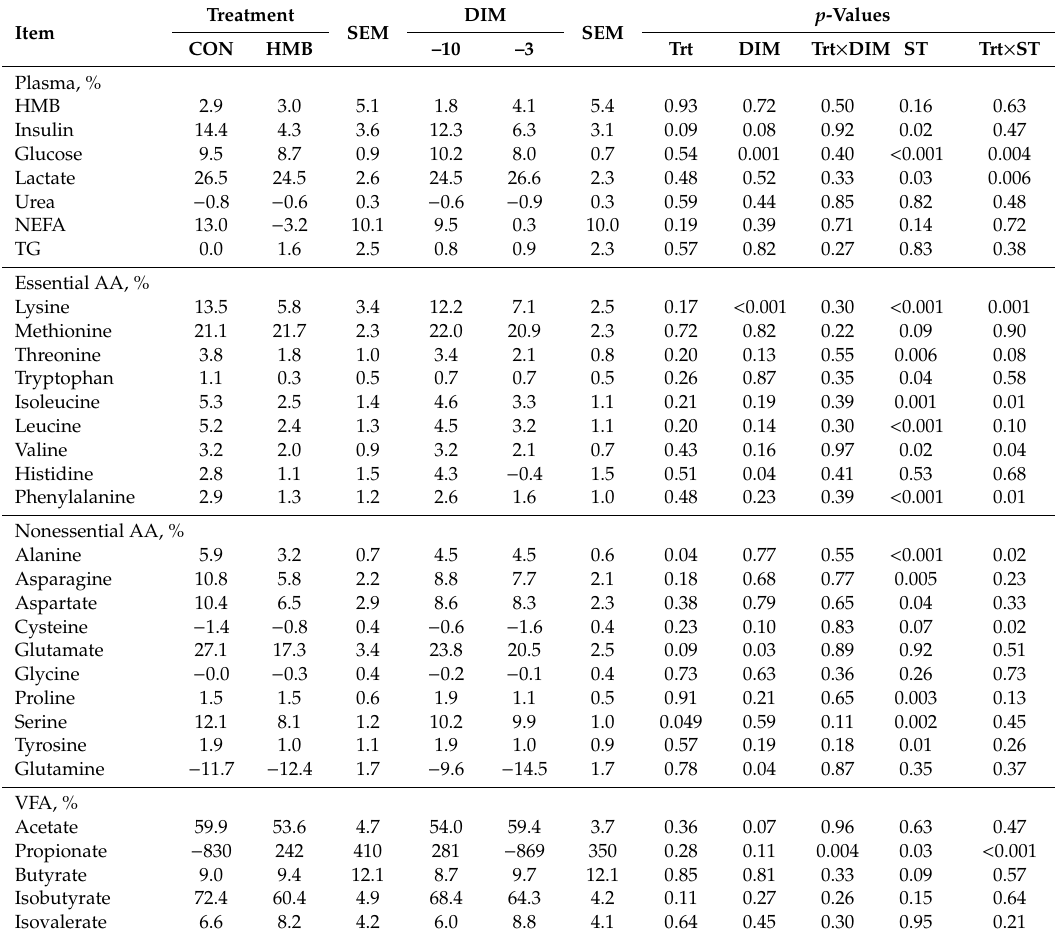
Table 7. Femoral extraction of metabolites of control (CON) and HMB-supplemented (HMB) sows during late